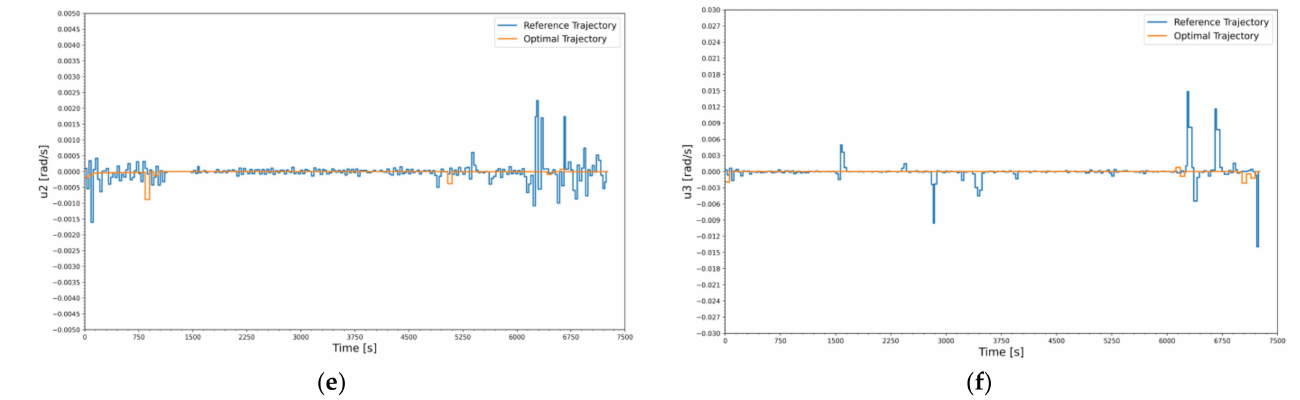
Figure 4. Comparison of reference and fuel-optimal trajectories: ( a ) true air speed vs. time; ( b ) flight path angle vs. time; ( c ) heading vs. time; ( d ) control u 1 vs. time; ( e ) control u 2 vs. time; and ( f ) control u 3 vs. time.